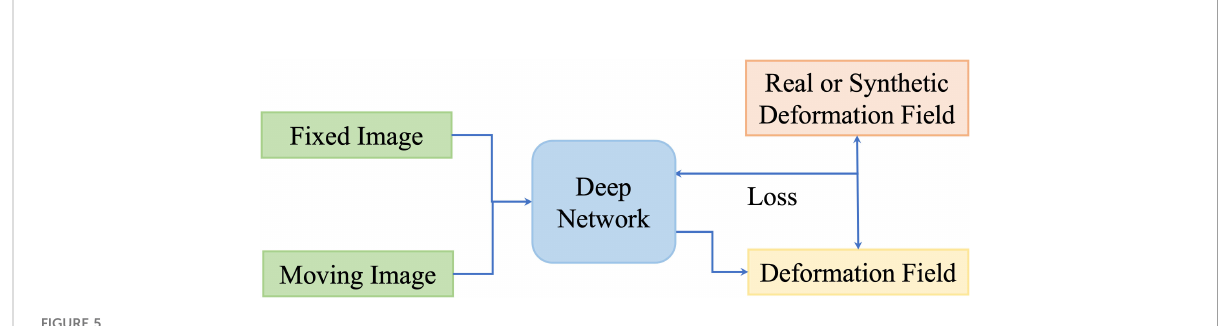
FIGURE 5 Illustration of fully supervised registration